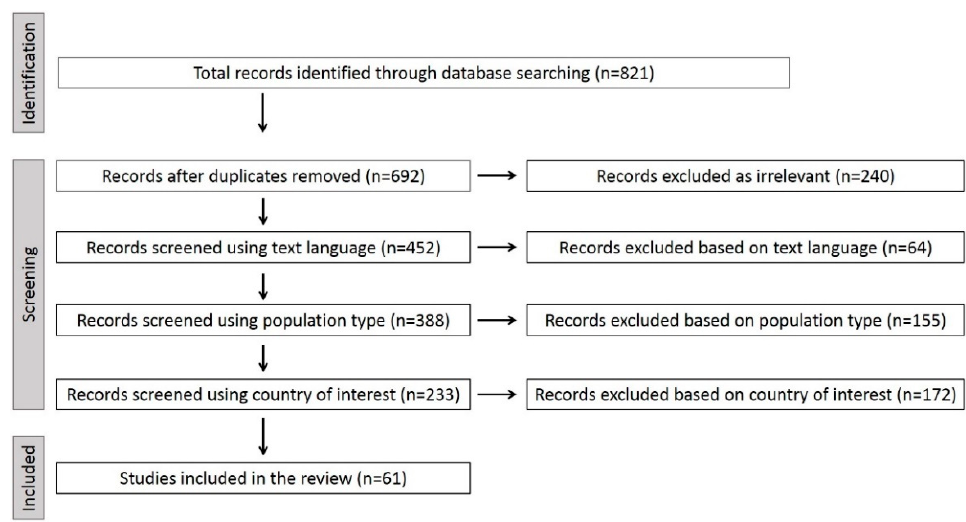
Figure 3. European countries with reported flood ‐ related waterborne diseases (NO: Norway; SE: Sweden; FI: Finland; DK: Denmark; NL: Netherlands; IE: Republic of Ireland; UK: United Kingdom; ES: Spain; FR: France; DE: Germany; AT: Austria; HU: Hungary; IT: Italy; GR: Greece). A case ‐ crossover study analyzed rainfall ‐ induced drinking water ‐ related outbreaks reported in England and Wales for the period extending from 1910 to 1999 following both